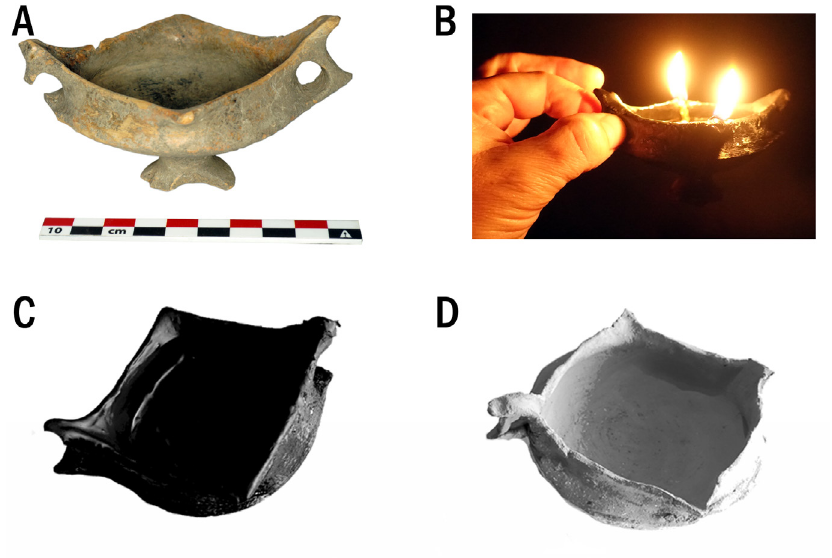
Figure 6. Bronze Age juglet from Idjoš Gradište (Serbia) and the 3D print of the same object used for testing it as a lamp (Pho- tograph by B. Molloy, 3D model and print by M. Milić, clay replica by B. Molloy, lamp experiment photograph by B.